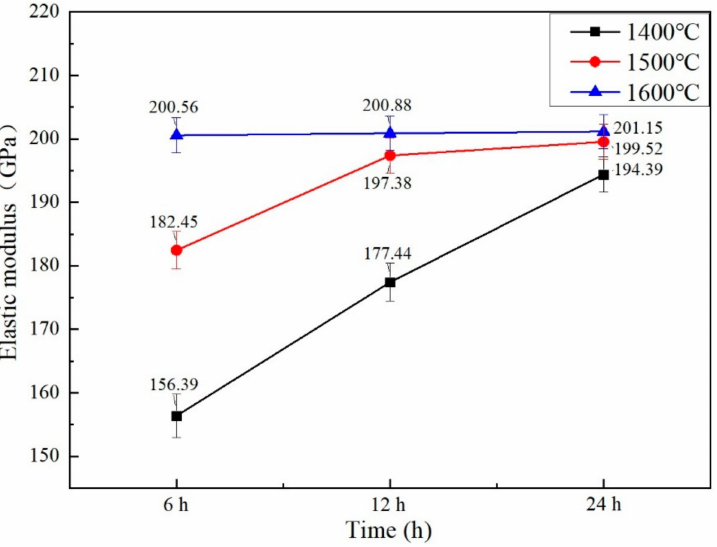
Figure 7. The sintered Gd 2 O 3 bulks’ elastic